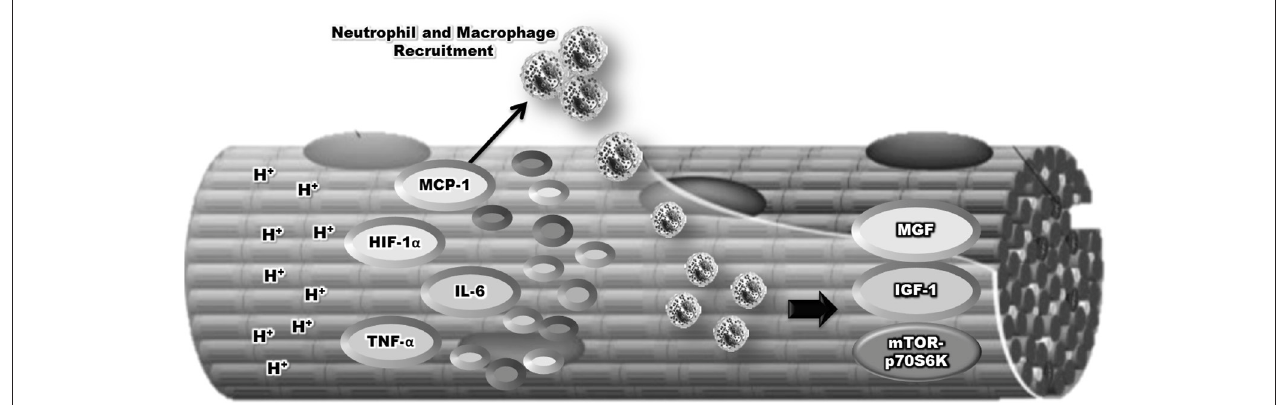
FIGURE 3 | Relationship between inflammatory, neutrophil, and macrophage in the remodeling of skeletal muscle mass induced by blood flow restriction plus strength training.